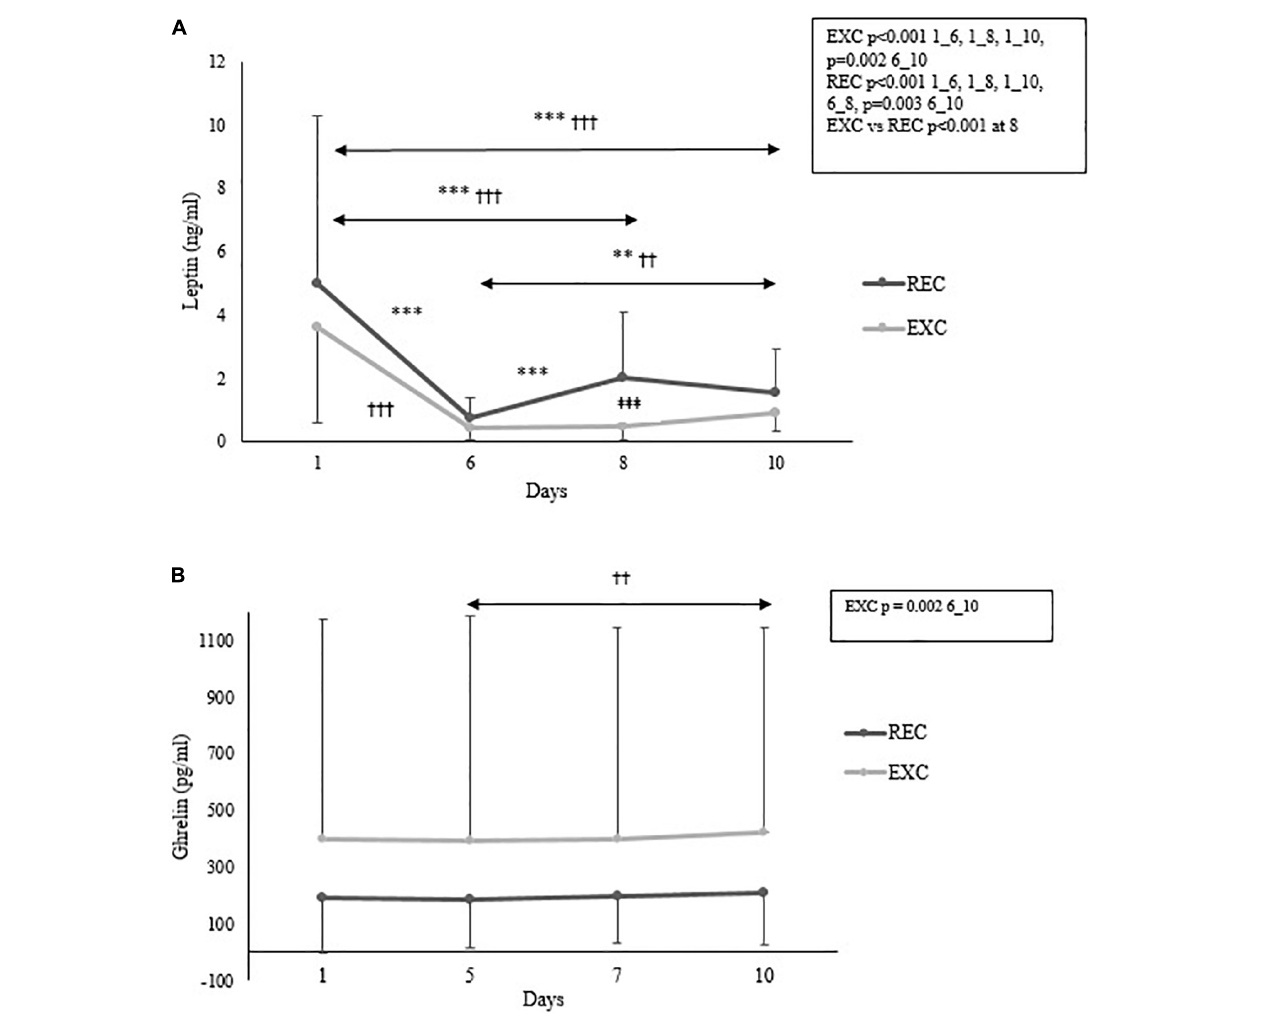
FIGURE 2 | Changes in serum (A) leptin and (B) ghrelin concentrations within and between the REC and EXC groups. For leptin, a number of subjects in the REC and EXC groups were daily 26, 22, 22, 20 and 42, 26, 27, 25, respectively. For ghrelin n = 17 (on all days) in the REC group and n = 23, 23, 23, 22 in the EXC group for days 1, 6, 8, 10 respectively. ∗ REC, † EXC, and ‡ Between groups. ∗∗ , †† p < 0.01; ††† , ‡‡‡ , ∗∗∗ p <